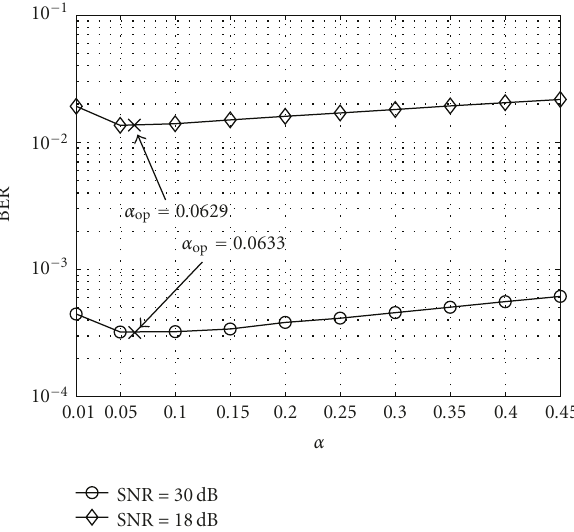
Figure 5: BER performance under di ff erent power allocation ratio